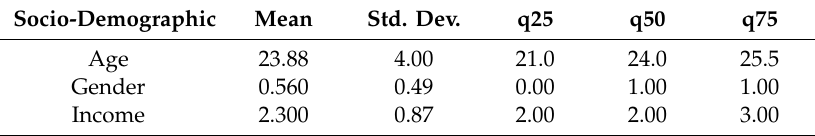
Table 1. Summary statistics of the explanatory variables of the model ( n =